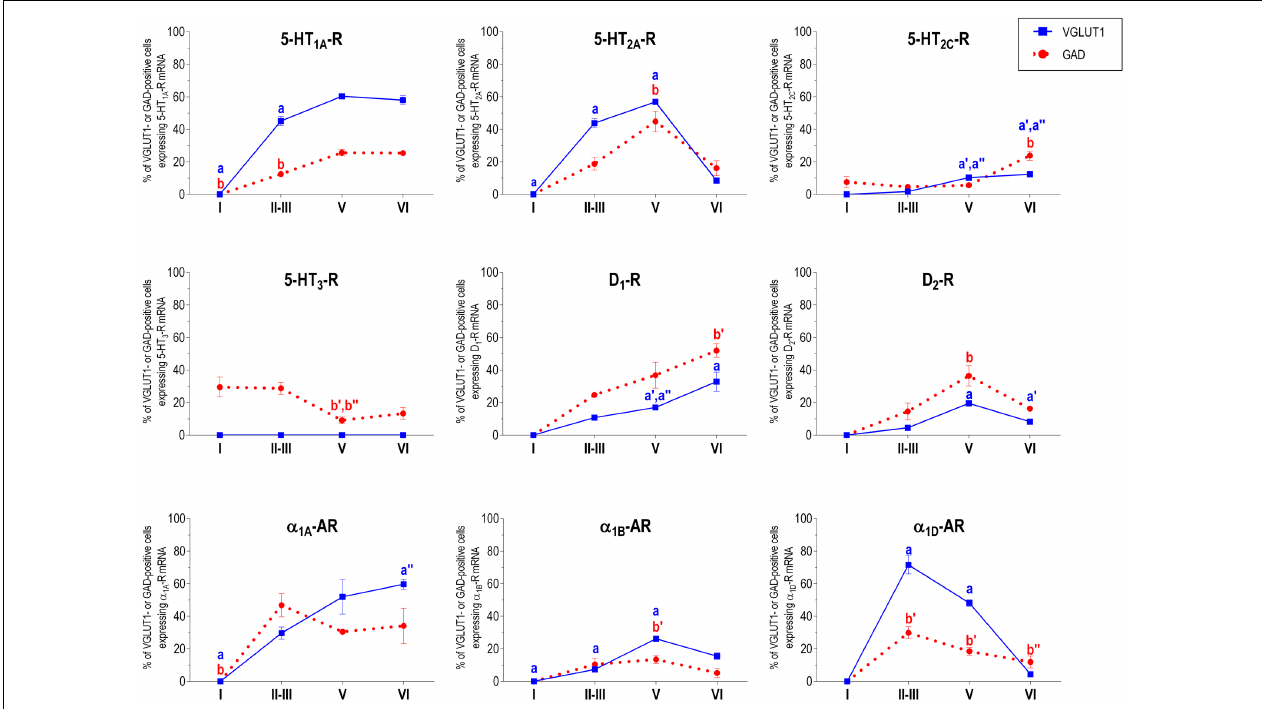
FIGURE 4 | Percentages of pyramidal (VGLUT1-positive) and GABA (GAD-positive) neurons expressing the nine monoamine receptors studied in the different layers of cingulate area of medial prefrontal cortex. a p < 0.05 vs. rest of layers, a (cid:48) p < 0.05 vs. layer I; a (cid:48)(cid:48)(cid:48) p < 0.05 vs. layer II–III; a (cid:48)(cid:48)(cid:48) p < 0.05 vs. layer V (for VGLUT1 graphs). b p < 0.05 vs. rest of layers, b (cid:48) p < 0.05 vs. layer I; b (cid:48)(cid:48) p < 0.05 vs. layers II–III; b (cid:48)(cid:48)(cid:48) p < 0.05 vs. layer V (for GAD graphs), one-way ANOVA followed by Tukey’s